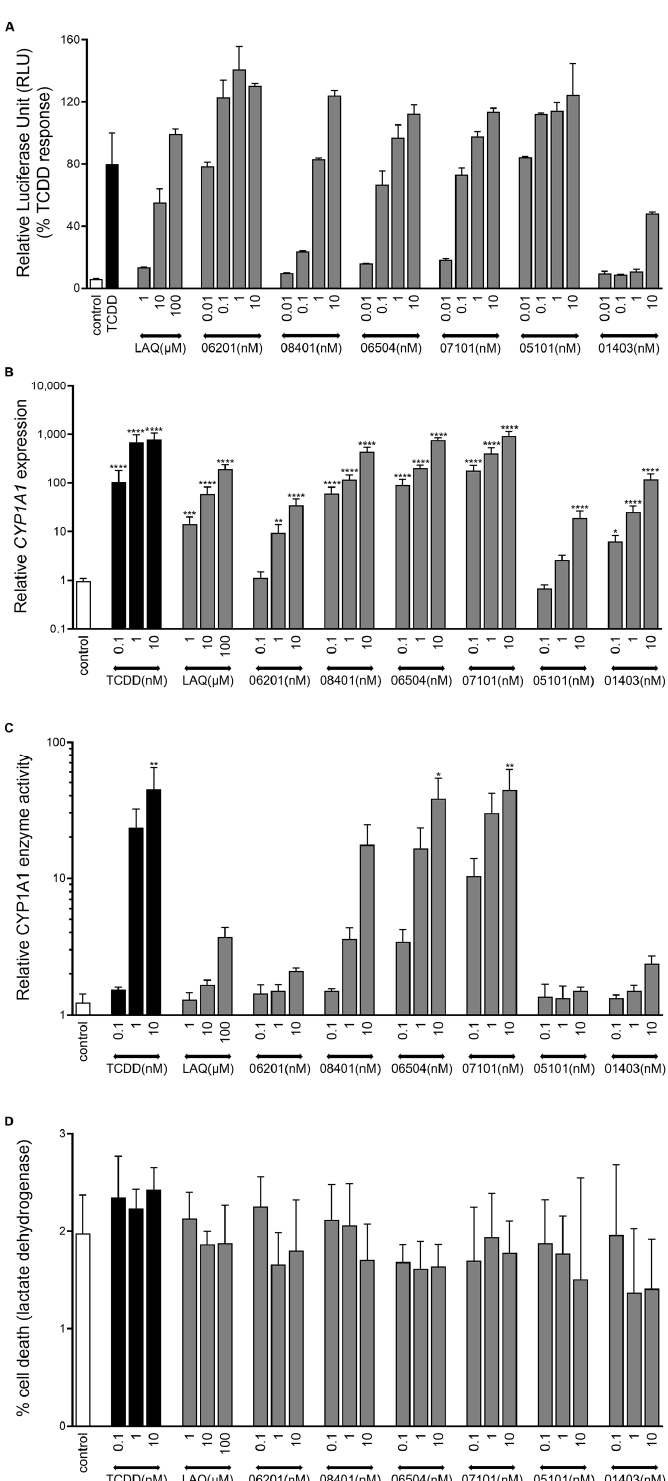
1 Figure 2. Induction of AHR activity by IMA-derivatives. ( A ) HepG2 40/6 cell cultures stimulated for 4 h with a concentration series of LAQ and IMA-compounds. TCDD (10 nM) was used as a full AHR agonist and set at 100% luminescent activity ( n = 2). ( B ) CYP1A1 mRNA expression levels, ( C ) CYP1A1 enzyme activity (luminescent assay), and ( D ) percentage cell death (24 h measurement, lactate dehydrogenase (LDH) assay) of primary human keratinocytes ( n = 3) stimulated for 48 h (re-stimulated after 24 h) with a concentration series of the IMA-compounds, LAQ, and TCDD. * p < 0.05, ** p < 0.01, *** p < 0.001, **** p < 0.0001. Mean +/ −